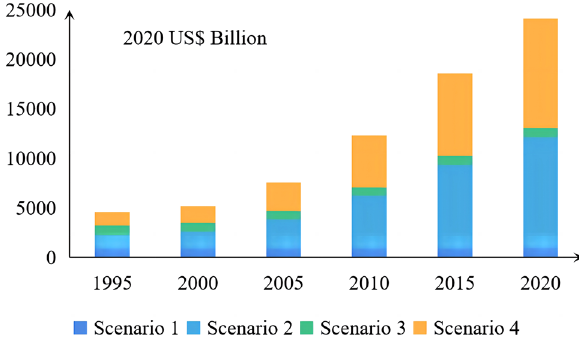
Figure 4. The ecosystem service scarcity values (ESSVs) under different scenarios (unit: 2020 US$